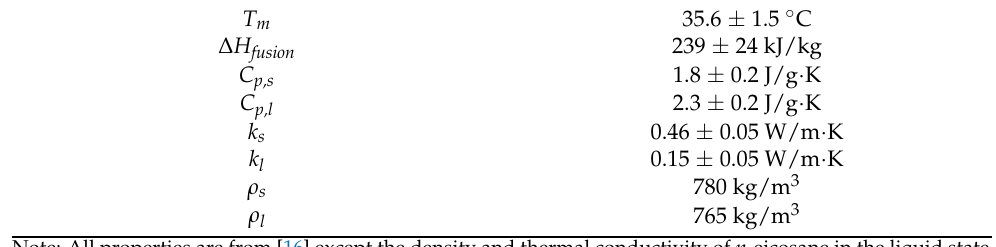
Table 2. Properties of n